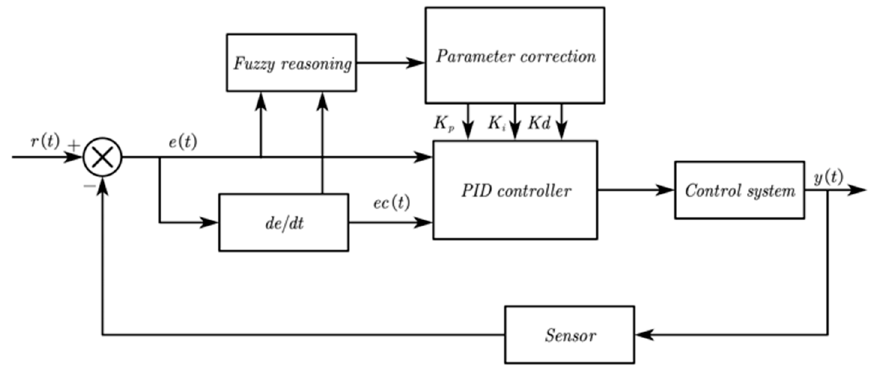
Figure 8. Principle block diagram of the fuzzy PID controller.